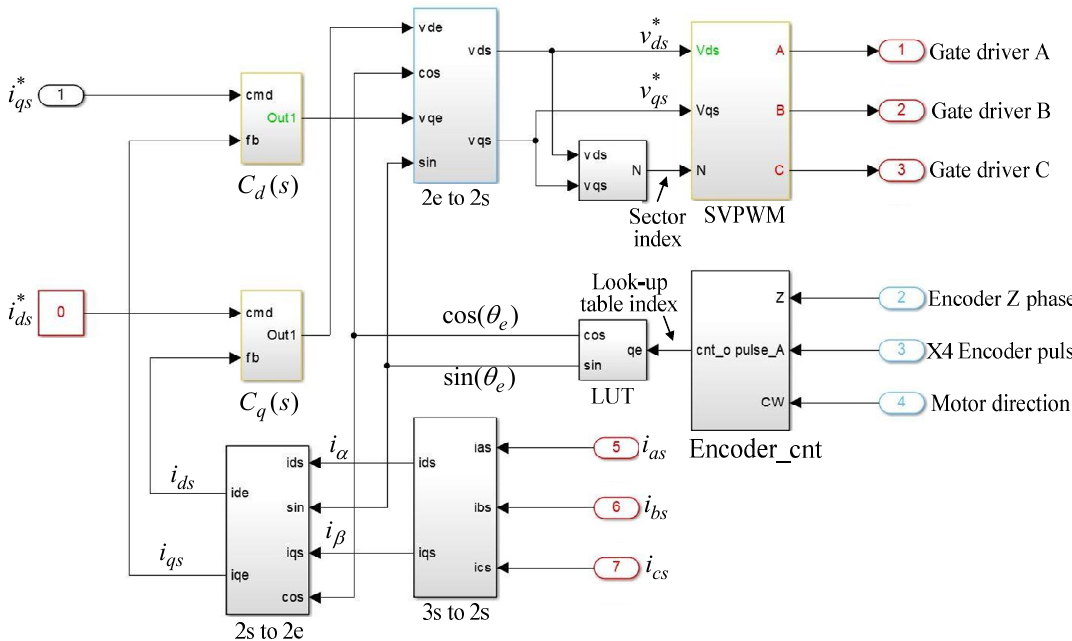
Figure 3. The block diagram of current vector